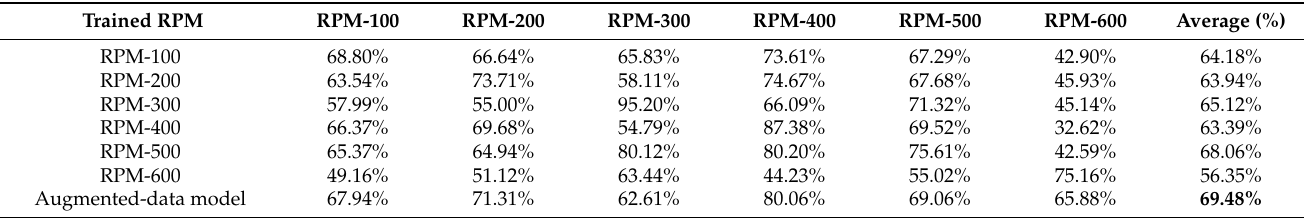
Table 6. Comparison on the performance of failure detection model where the trained model is using one RPM and the tested data is from another RPM. The data-augmentation model is useful for transfer the learning across different RPMs. The absolute enhancement in the average accuracy across all RPMs is 6% while it is 13% over the worst single-RPM